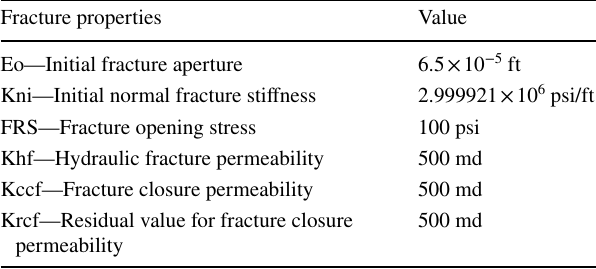
Table 3 Summary of Barton–Bandis fracture properties implemented on the two-dimensional block model